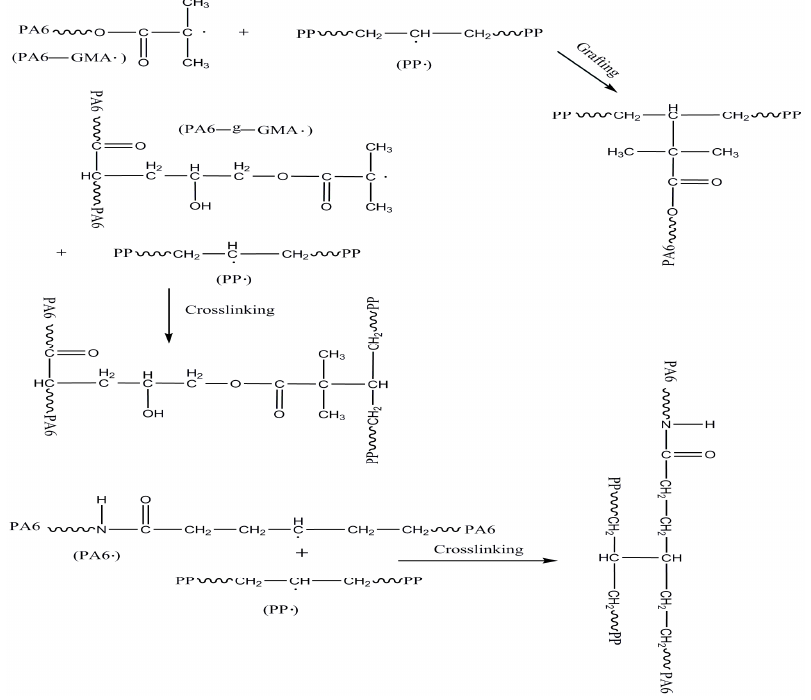
Scheme 3. Suggested mechanisms of interfacial cross-copolymerization.